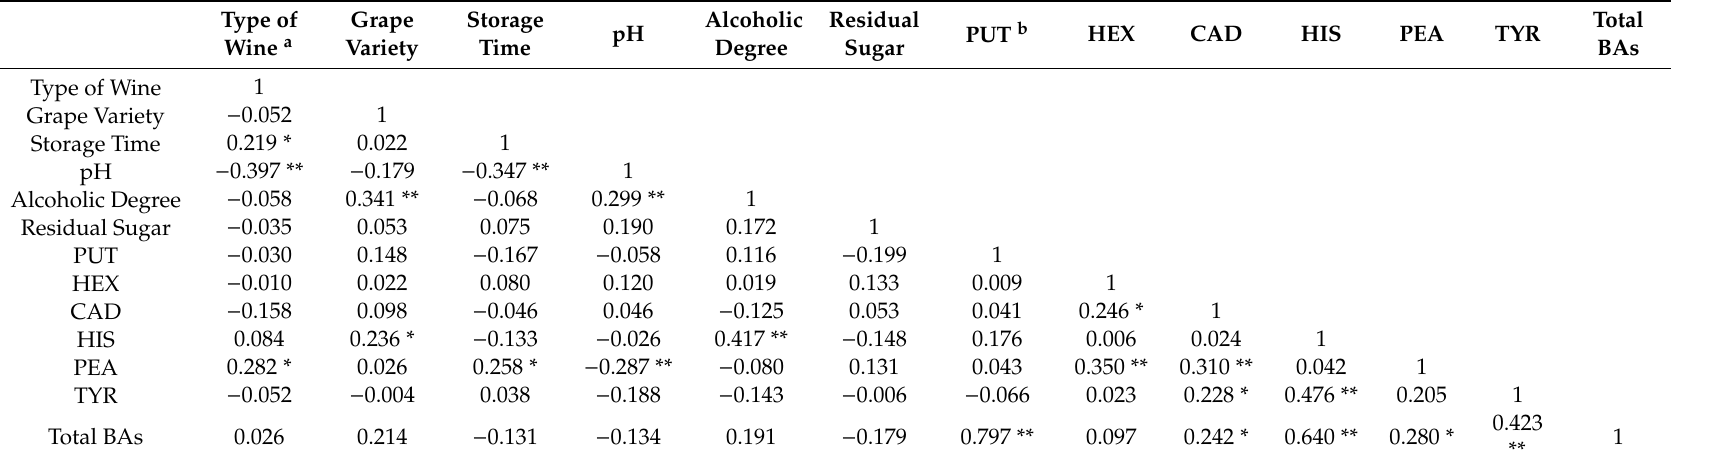
Table 4. Correlation analysis between BAs and wine